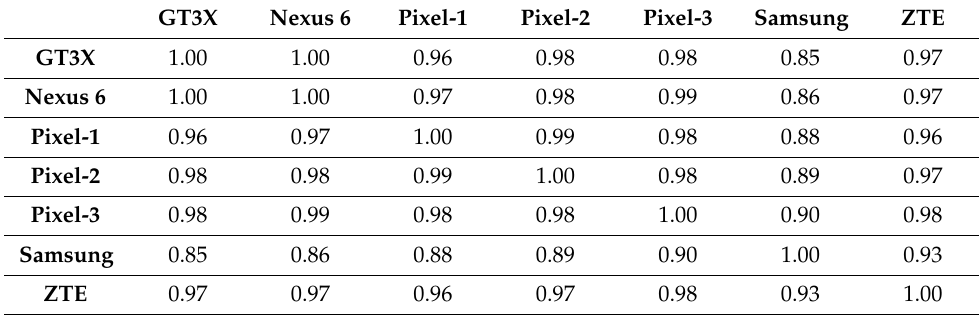
Table 5. Pairwise correlation for the second experimental